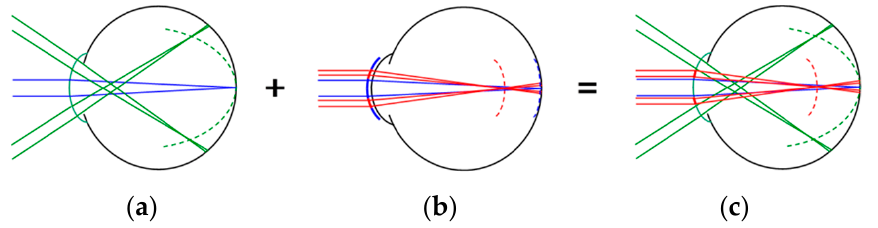
Figure 1. Summary optical concept of the multifocal orthokeratology (MOK) lens. ( a ) Conventional orthokeratology induces peripheral myopic defocus while correcting on-axis refractive error. ( b ) Dual- focus optics creates simultaneous, on-axis myopic retinal defocus. ( c ) The multifocal treatment zone is molded onto the corneal surface. The MOK lens combines both optical